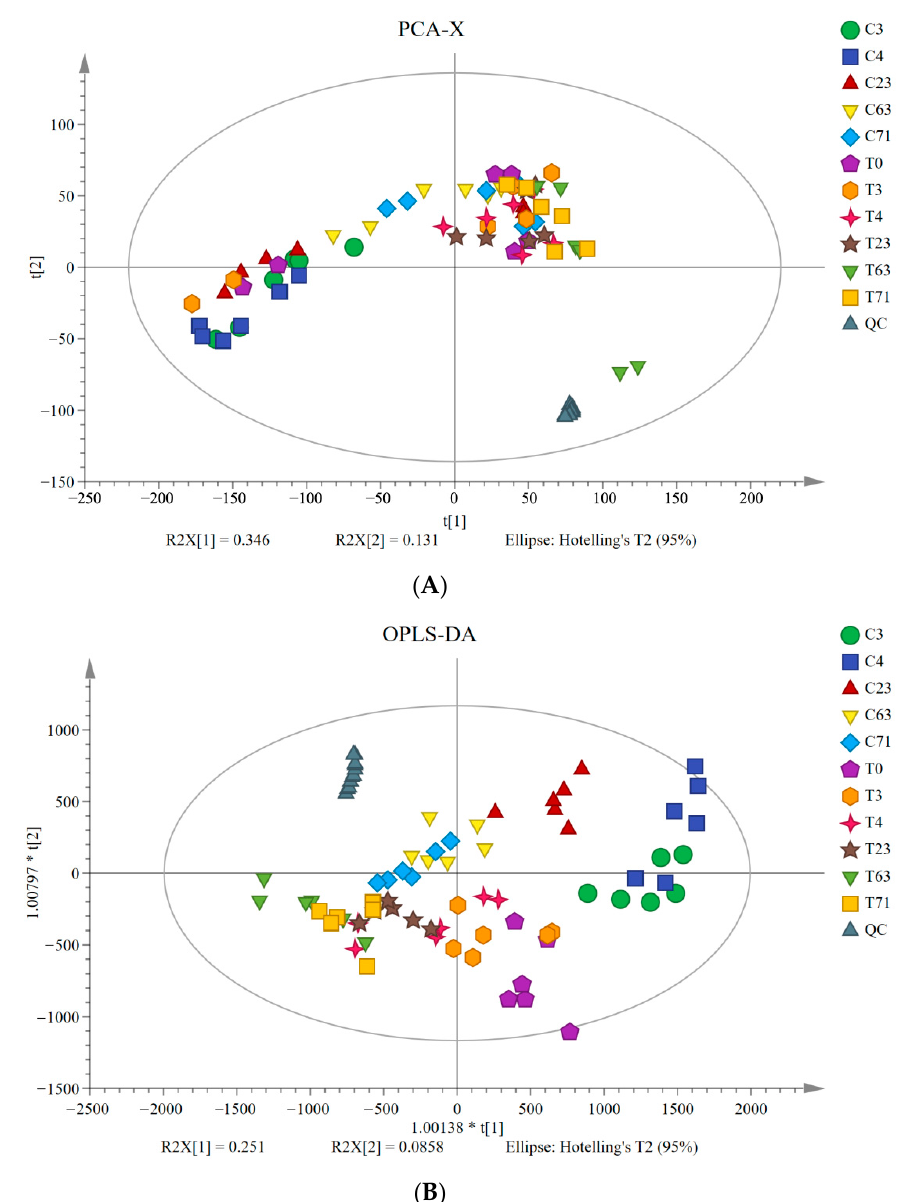
Figure 4. Principal component analysis (PCA) score plots and orthogonal projections to latent structures-discriminate analysis (OPLS-DA) score plots showed the metabolomics trajectory of picked “Guiwei” litchi leaves in girdling group and control group under floral induction. ( A ): The PCA score plot of all metabolites from the six biological replicates of the litchi leaves collected at all sampling time. Scores were plotted with principal component 1 in the x -axis and principal component 2 in the y -axis. ( B ): OPLS-DA score plot of all metabolites from the six biological replicates of the litchi leaves collected at all sampling time. QC indicates the quality control sample.